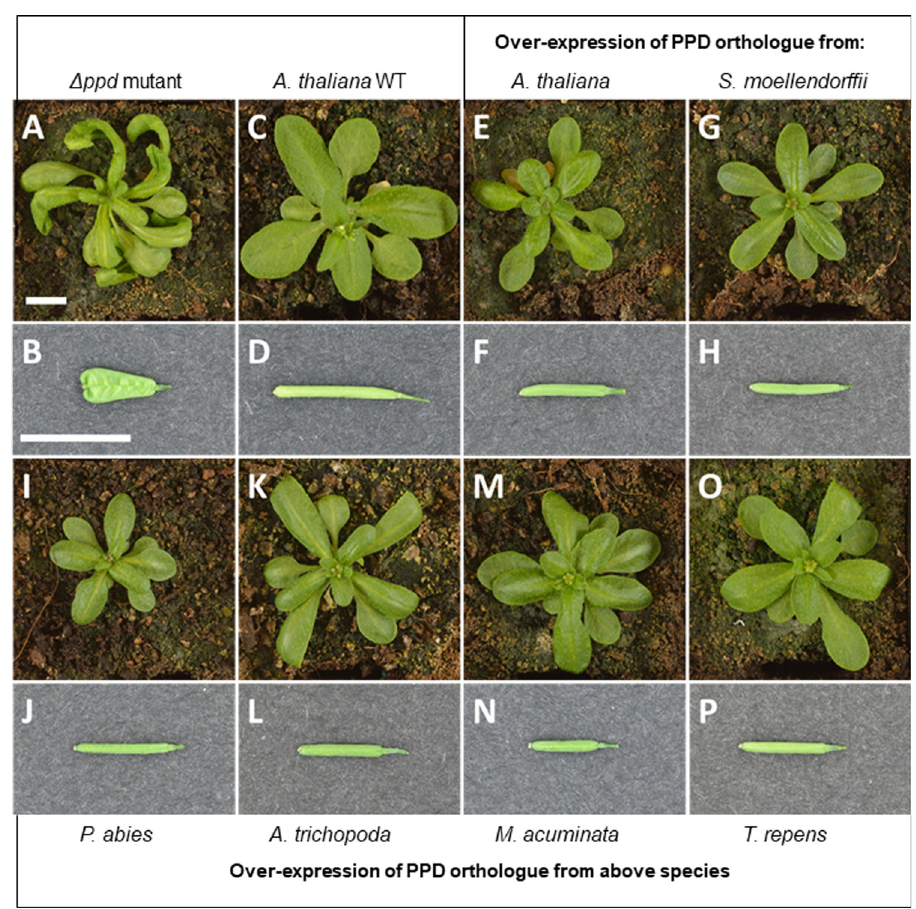
Fig 4. The Arabidopsis thaliana Δ ppd mutant was complemented with PPD from a broad range of multicellular land plants. In Arabidopsis the Δ ppd mutant has a distinct propeller shaped rosette with transversely domed leaves (A) and dimpled, short paddle shaped siliques (B); these contrast to the WT rosette of straight, transversely flat leaves (C) and smooth, elongated torpedo shaped siliques (D).Over-expression of PPD from A . thaliana (E & F), and